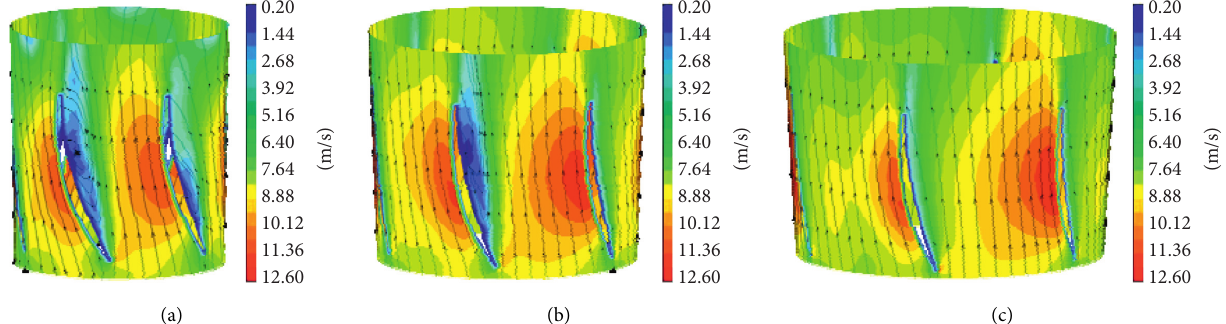
). (c) Larger discharge rate condition ( α L > α 0